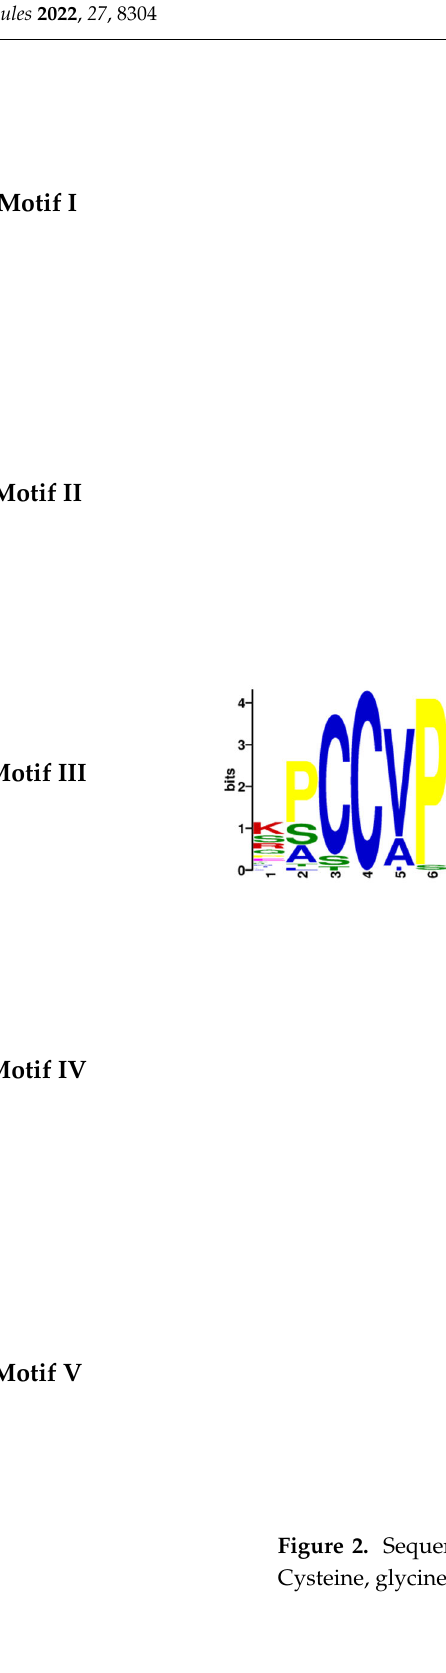
The coding regions of these zebrafish BMP genes were encoded for amino acid (aa) sequences with a length of 347–501 residues in which the shortest protein was BMP7b (347aa), and the longest protein was BMP6 (501aa) (Figure 3). Furthermore, a phylogenetic relationship analysis inferred that these 38 proteins were clustered into five major clades